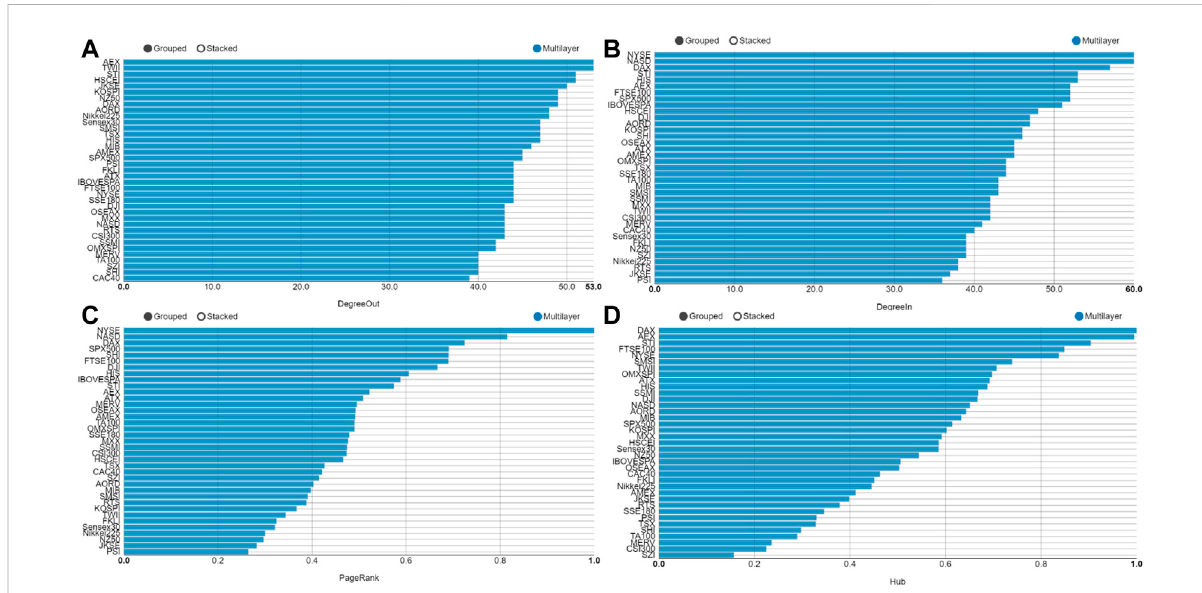
FIGURE 6 (Coloronline)Parametersofeachlayernetworkatthetimeofglobal fi nancialcrisis. (A) Theout-degreeofmultilayernetwork, (B) Thein-degree of multilayer network, (C) The PageRank of multilayer network, (D) the hub of multilayer network.